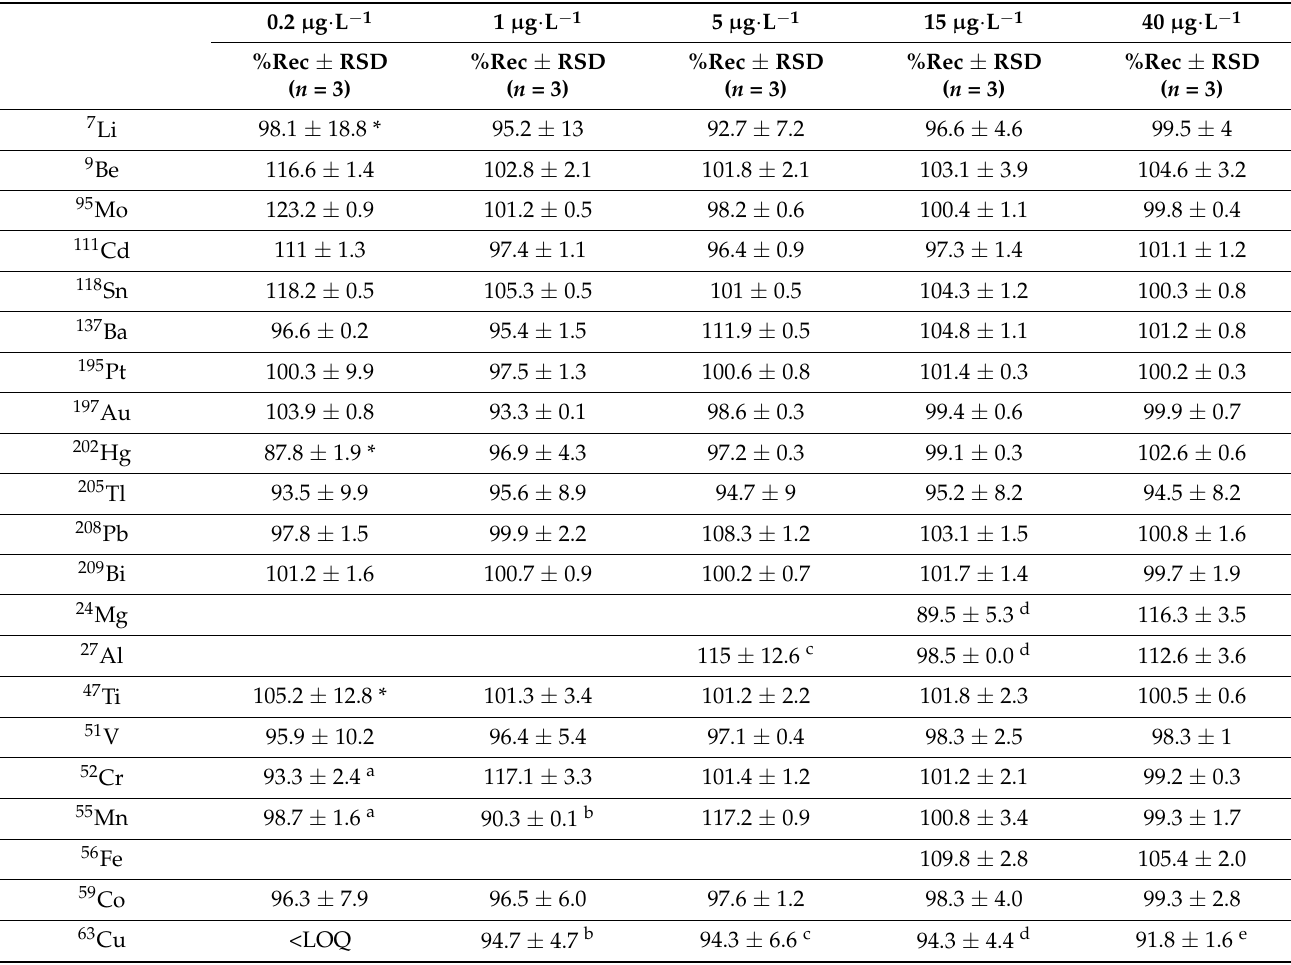
Table 2. Percent recoveries of control samples for protein powder